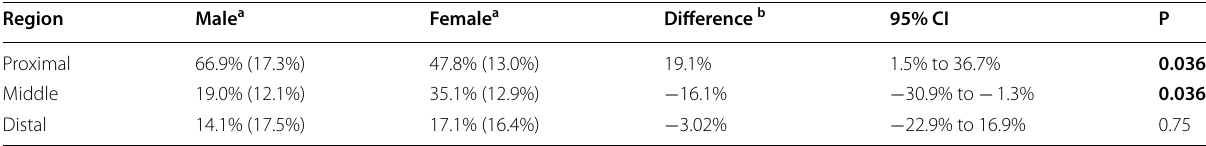
a Data are presented as mean (standard deviation). Percentage value represents percentage of total ACL vascularity b Difference is calculated as Male value - Female value (positive represents greater value from Male group)